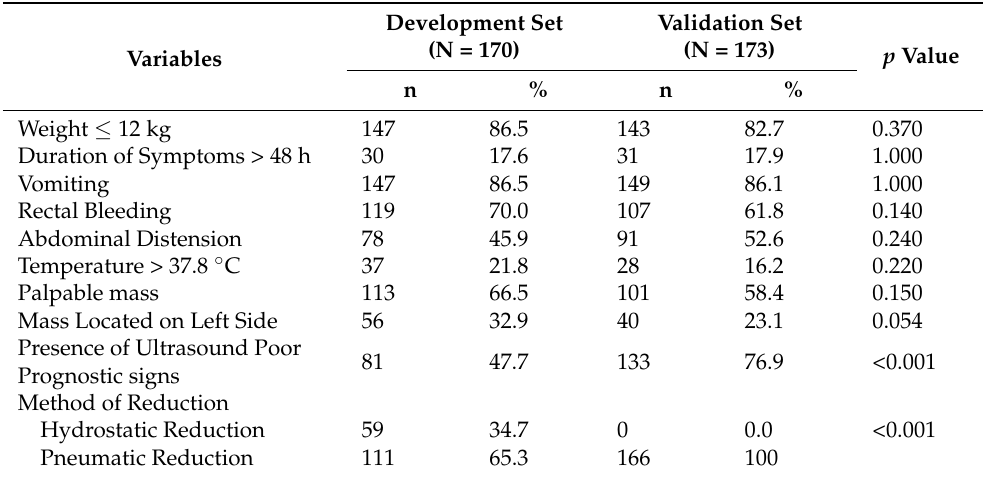
Table 4. Comparison of the total CMUI score and the result of reduction between development set (N = 170) (imputed data) and validation set (N = 173) of intussusception patients.